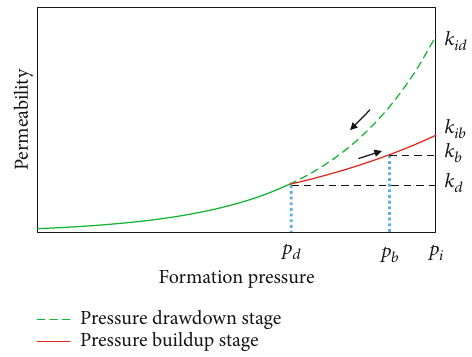
Figure 2: The change of reservoir permeability with